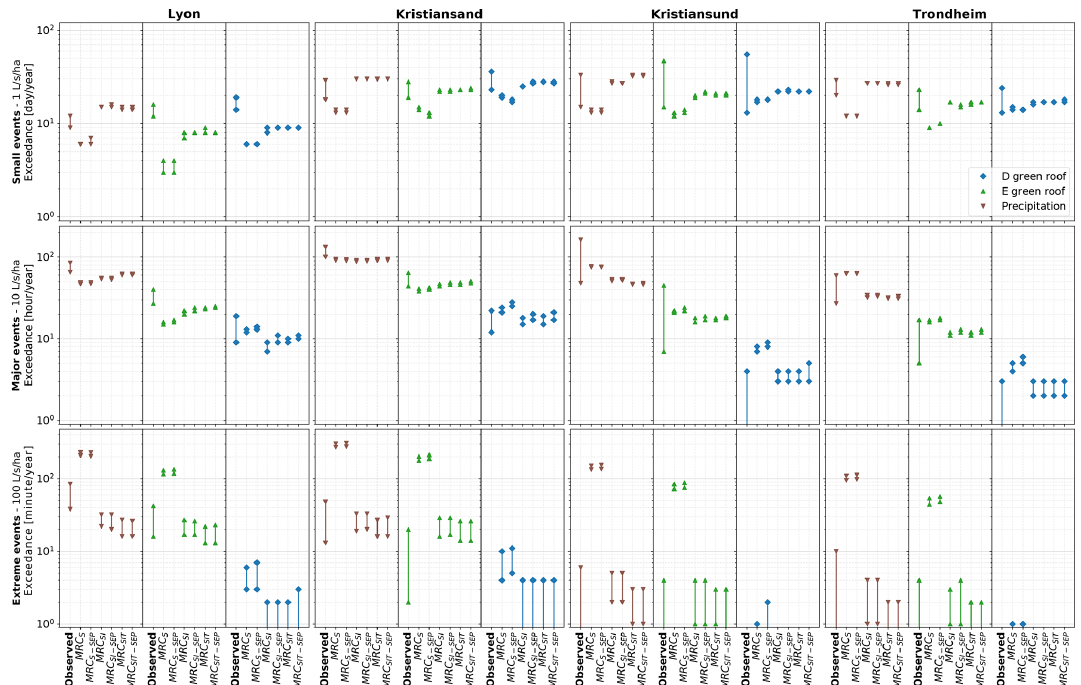
Figure C1. Performance of the downscaled time series in Lyon, Kristiansand, Kristiansund and Trondheim; exceedance frequency for small events, major events and extreme events. The stochastic variability linked to the downscaled time series is evaluated with the 5th to 95th percentiles. Observed represents the fine-resolution observed time series or simulation using this time series as input; the 5th to 95th percentiles were estimated with a 3-year moving window. Due to log axis, occurrences lower than 10 0 are not visible. Hydrol. Earth Syst. Sci., 26, 2855–2874, 2022